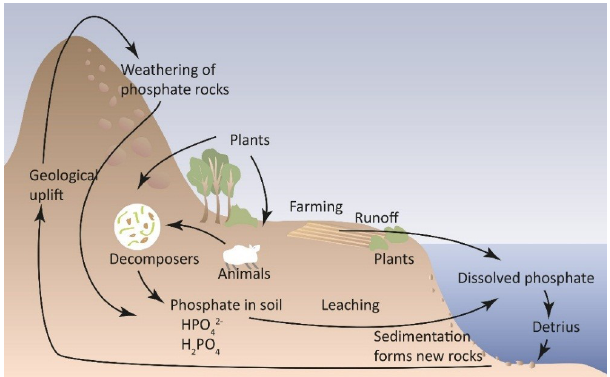
Figure 8. Schematic figure of the phosphorus